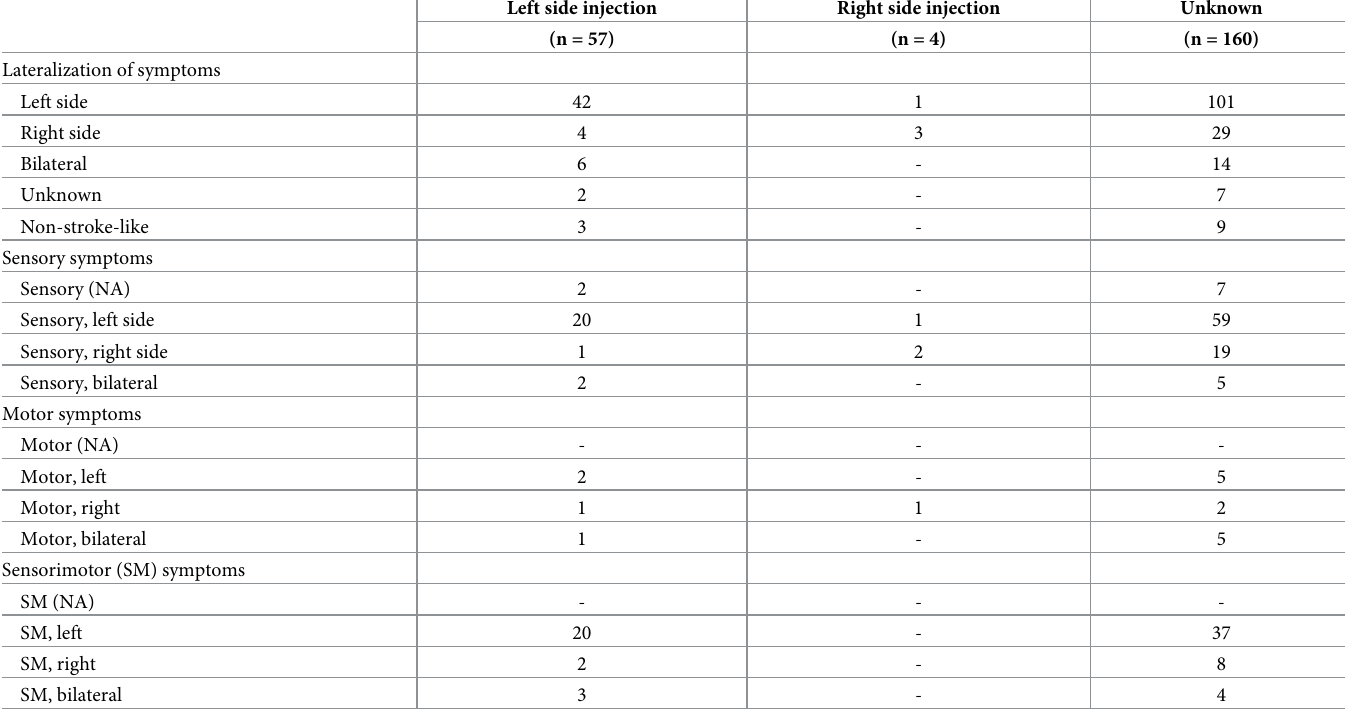
Table 2. Clinical characteristic with respect to neurological symptoms stratified by the vaccine injection